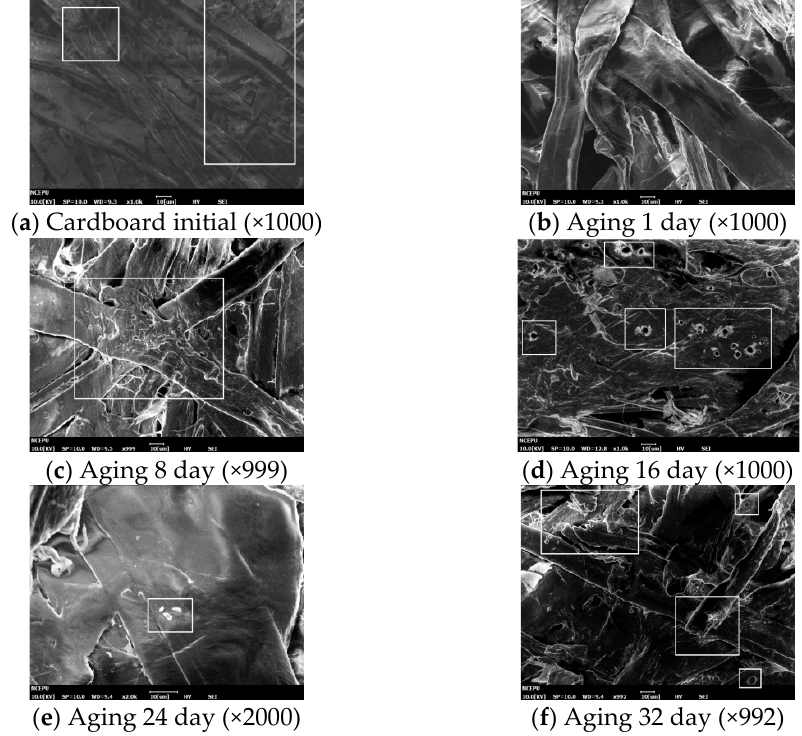
Figure 8. SEM image of insulation cardboard with different aging times. Table 2. Variation of pressboard surface during different accelerated thermal aging durations.